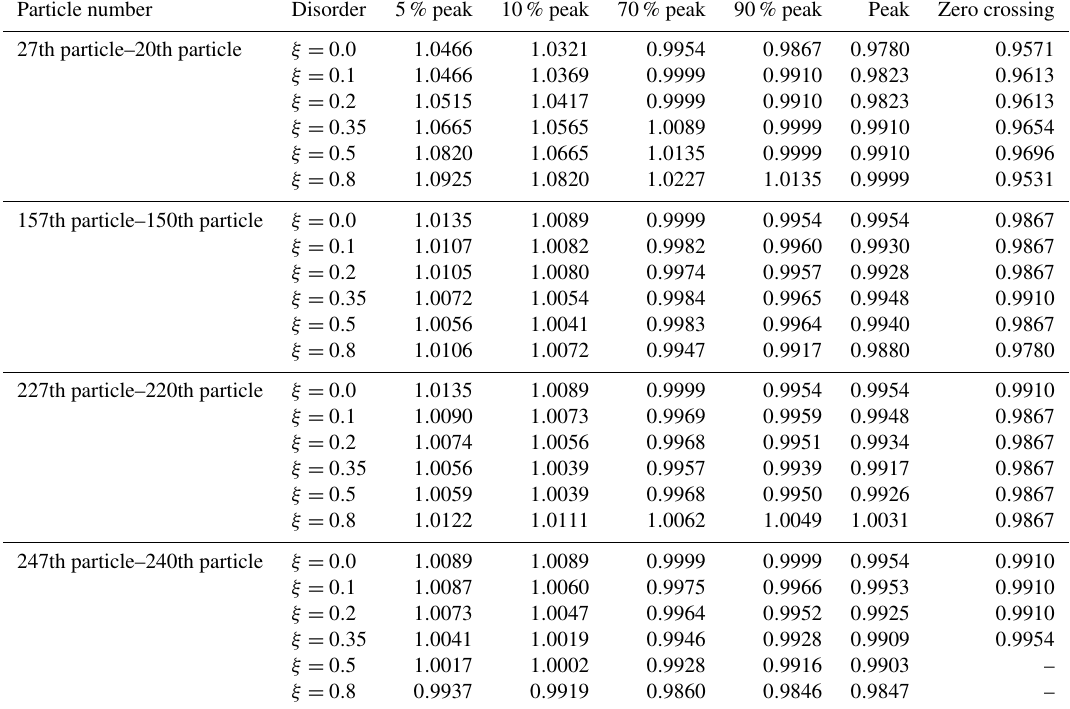
Table 6. Coherent wave velocity calculated from the time taken by the pulse to travel a common distance of separation (seven particles or elements) with time calculated in reference to 5, 10, 70 and 90% of the peak value and the peak value of the coherent wave